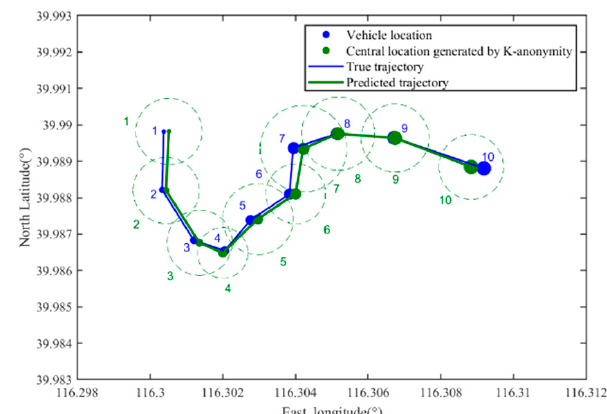
Figure 8. The predicted trajectory of a vehicle user with location privacy preservation method based on K-anonymity.